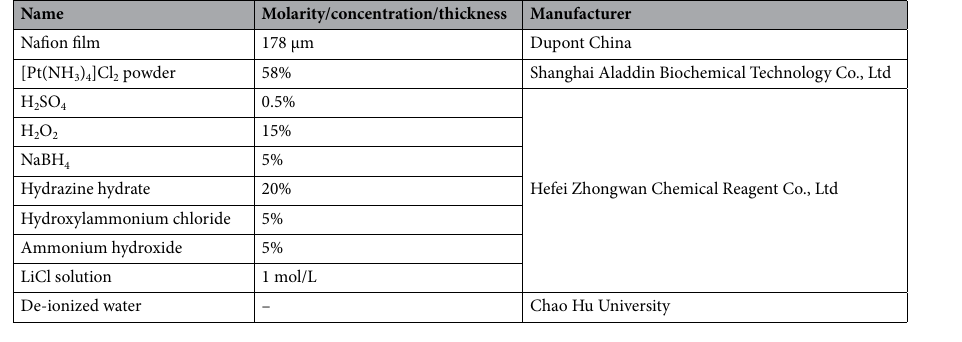
Table 1. Materials used in the